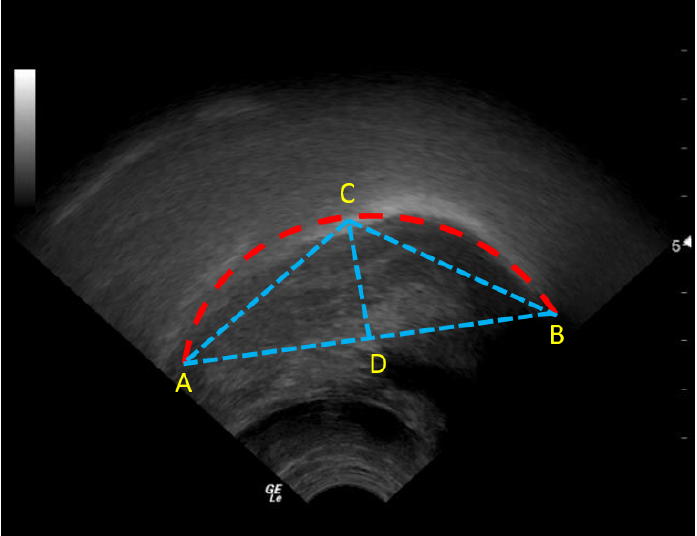
Figure 4. Shape-based evaluation measure. Point ( A ) is on the dorsal tongue part, point ( B ) is the point on the tongue tip, point ( C ) is the apex. Point ( D ) is the projection of point ( C ) on the ( AB )